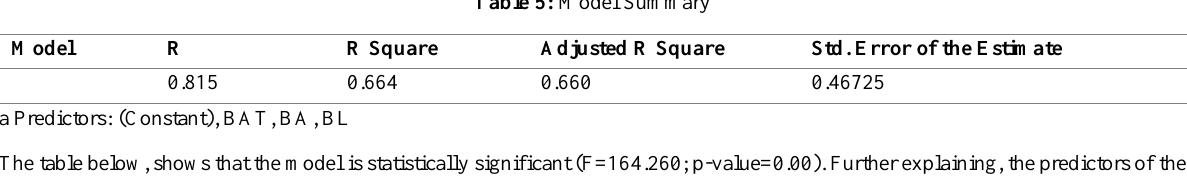
Table 5: Model Summary